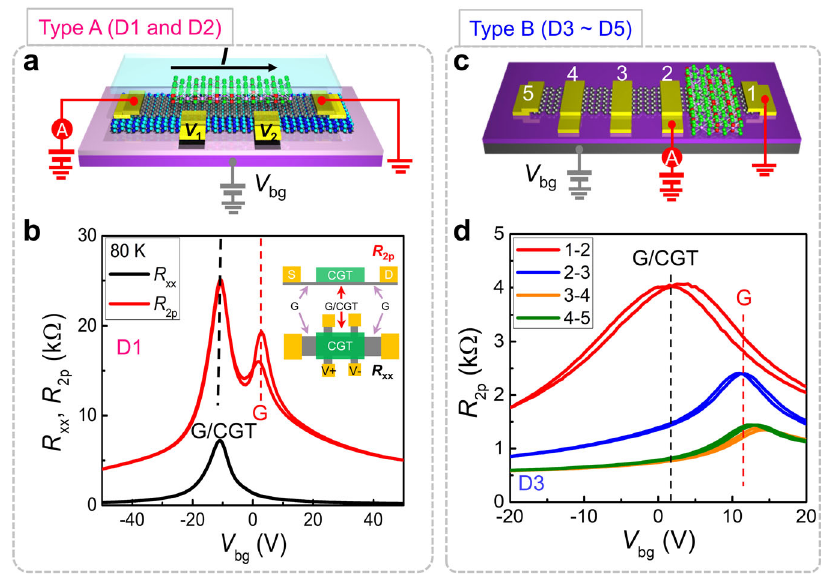
Fig. 2 Electron doping of graphene due to charge transfer from CGT. a , c Schematic illustration of device type A (D1 and D2) and B (D3 – D5), respectively. For type A, 2P (red) and 4P (black) con fi gurations are adopted. For type B, only the 2P con fi guration is used. b , d Corresponding transfer-characteristic curves of D1 and D3. Inset of ( b ) shows schematic diagrams for the measurement con fi guration of R 2p (upper) and R xx (lower), where the upper and lower illustrations are the side and top views,